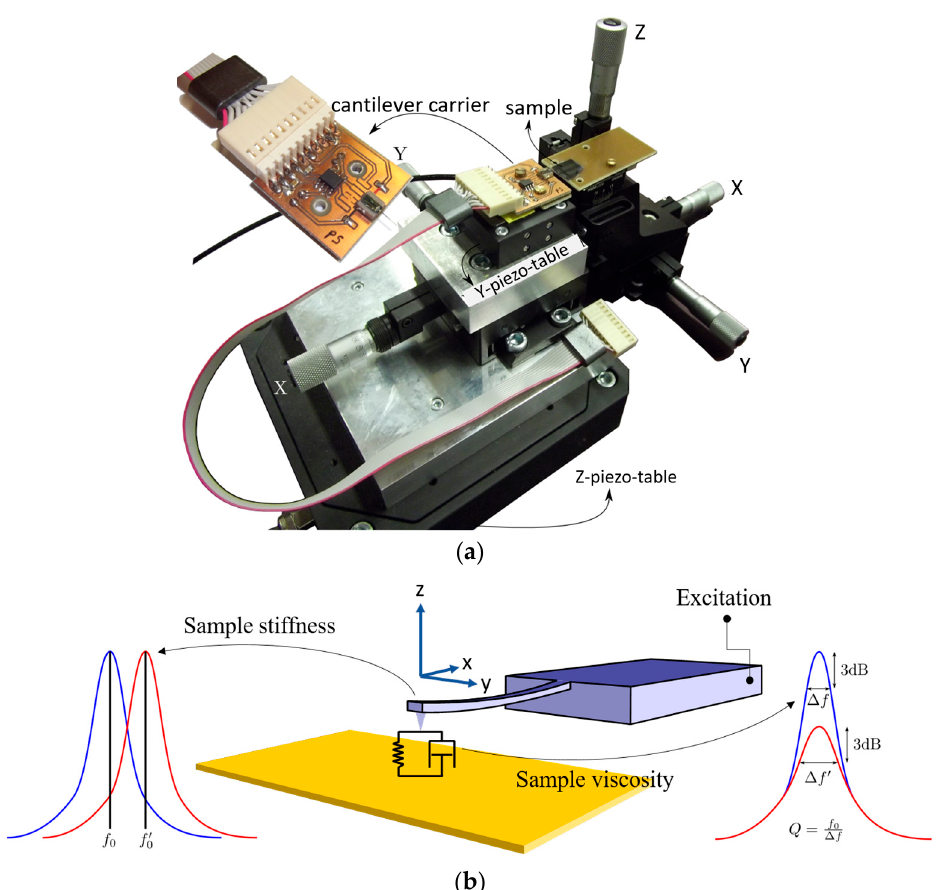
Figure 1. ( a ) Measurement setup and ( b ) schematic description of